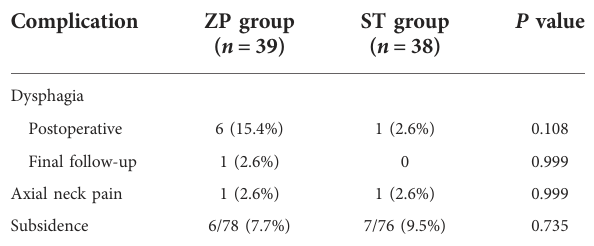
TABLE 5 Patients ’